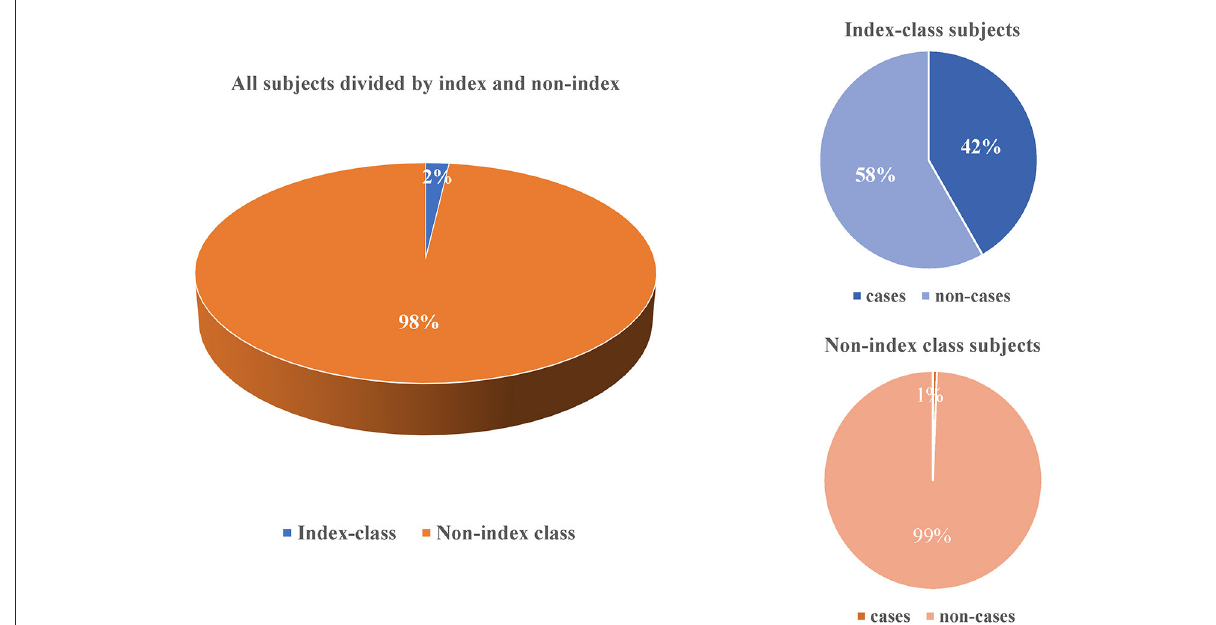
FIGURE2 Comparison for active tuberculosis between teachers and students in the index class and non-index class in this